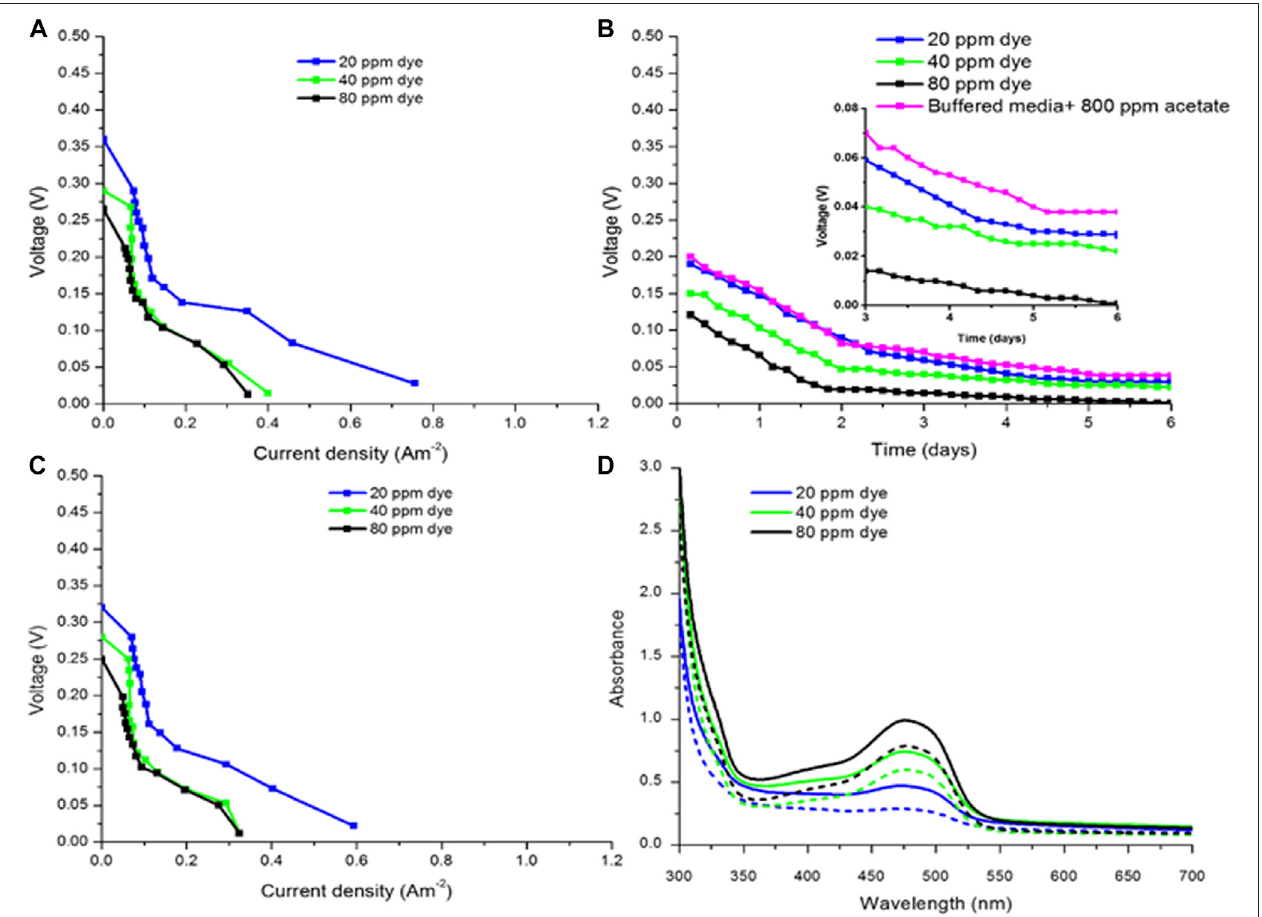
FIGURE 7 | MFC performance and dye decomposition with 20 – 80 ppm of A05 in the presence of 800 ppm acetate (A) 1 – 4 (dotted lines) and power curves (lines) B)PerformanceofMFCatconstantloadof100 Ω (C) LossinMFCperformancebefore(thicklines)andafterconstantloadin (B) (dottedlines) (D) UV-visspectraofA05at λ 483 nm before (thick lines) and after dotted 1 h load at 100 Ω